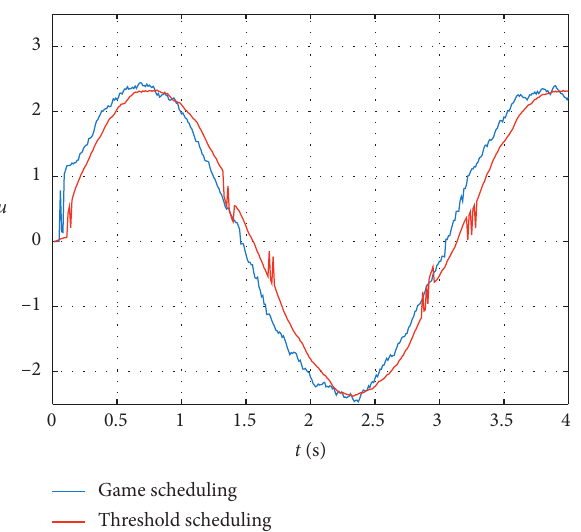
Figure 12: Comparison of the control values of the two control